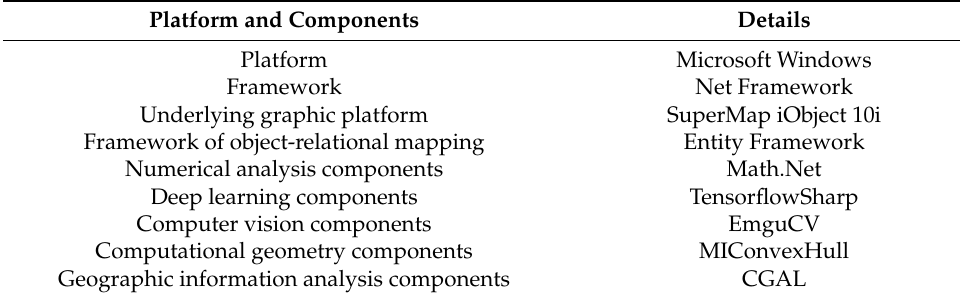
Table 2. Development platform and components.